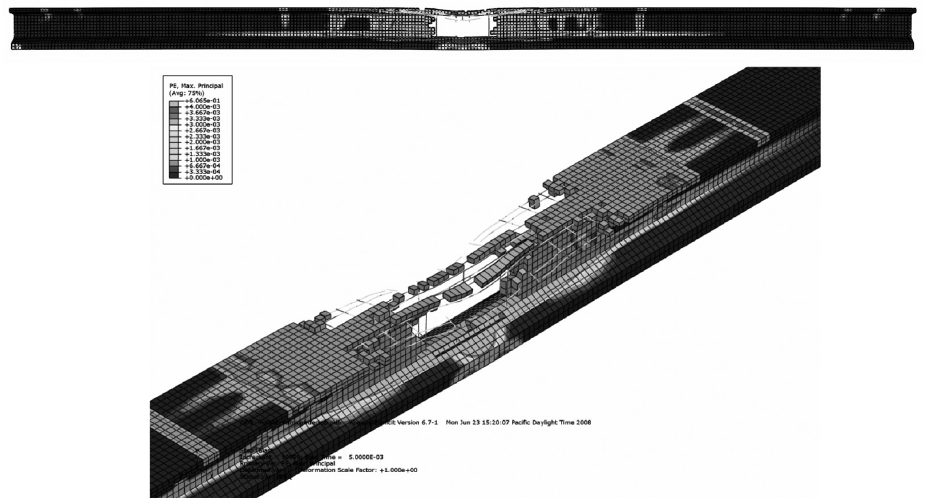
Fig. 8. Maximum principal plastic strain for the blast above the girder.